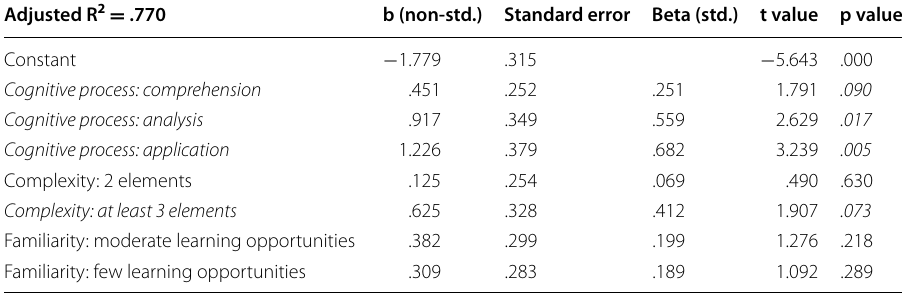
N 26 (number of test items for both dimensions of CCER); reference categories for the three characteristics: cognitive = process: retrieval, complexity: one element has to be processed, familiarity: many learning opportunities are provided